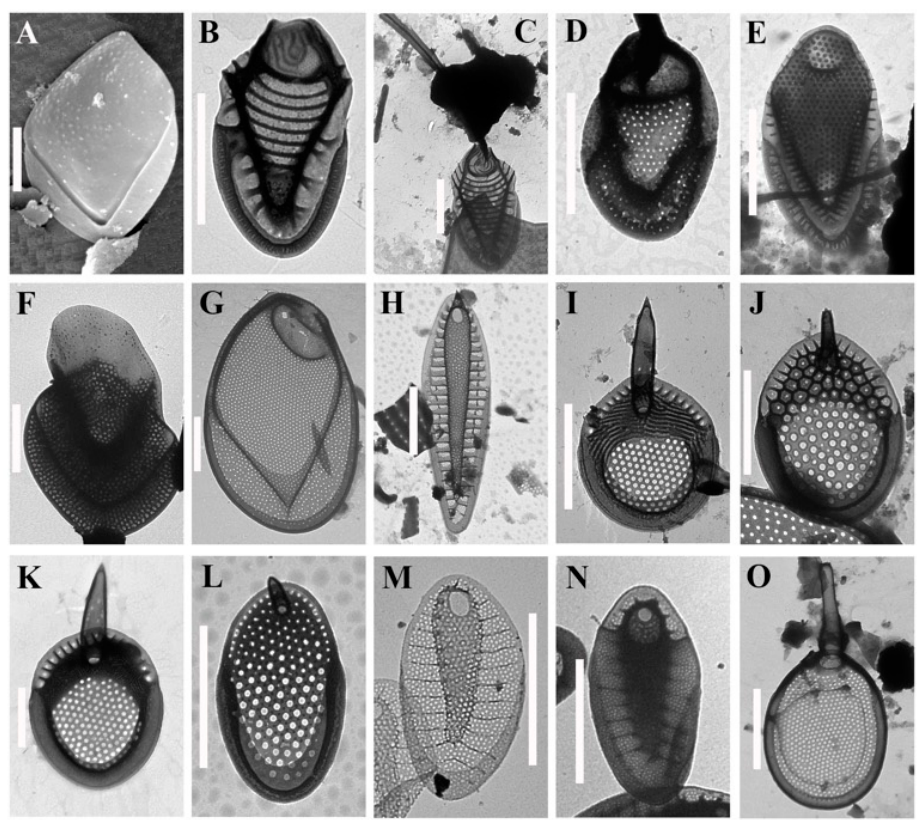
Figure 5. Scales of Mallomonas and Synura . ( A ) M. splendens . ( B ) M. striata sensu lato [48]. ( C ) M. striata var. serrata . ( D ) M. tonsurata . ( E ) M. tropica . ( F ) M. velari . ( G ) M. vietnamica . ( H ) Synura australiensis . ( I ) S. echinulata . ( J ) S. cf. longitubularis . ( K ) S. mammillosa . ( L ) S. papillosa . ( M , N ) S. petersenii sensu lato ( S. spp. from S. petersenii complex). ( O ) S. sphagnicola . Scale bars: ( A – J , L – O ): 2 μ m; ( K ): 1